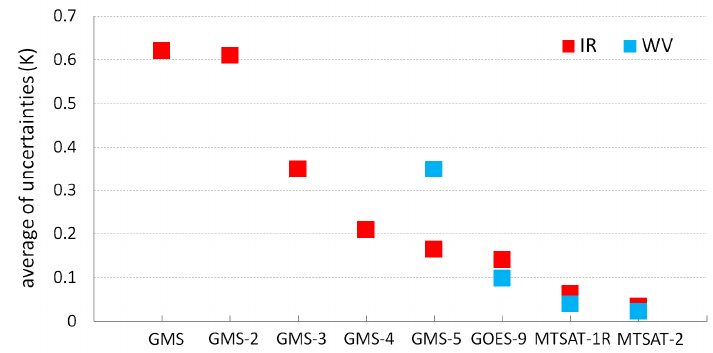
Figure 10. Average of uncertainties of corrected radiance (K) for the IR and WV channel.